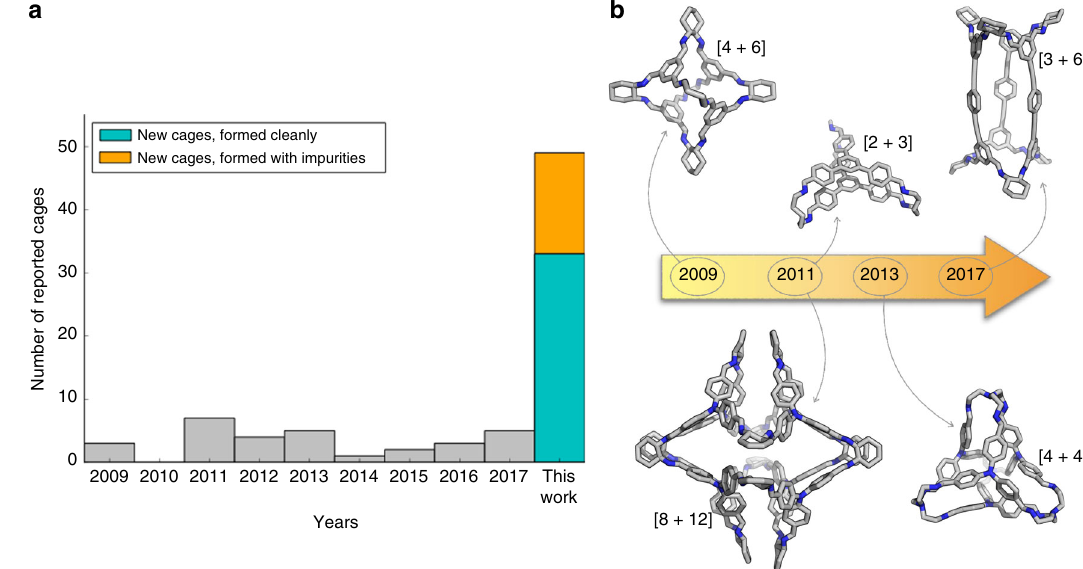
Fig. 1 High-throughput methods fused with computation provides a step-change in the discovery rate for new cage molecules. a Timeline shows the number of organic cage molecules reported by our research group using traditional, iterative experiments in period 2009 – 2017 (grey bars; total of 30 cages). The number of cage molecules synthesised in this new study is also shown: we achieved clean conversion to 33 cages (teal bar) plus partial formation of 16 others (orange bar). b Timeline showing variation in cage topologies studied by our group during the same